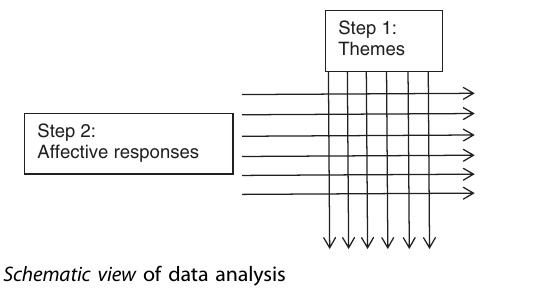
Fig. 1 Schematic view of data